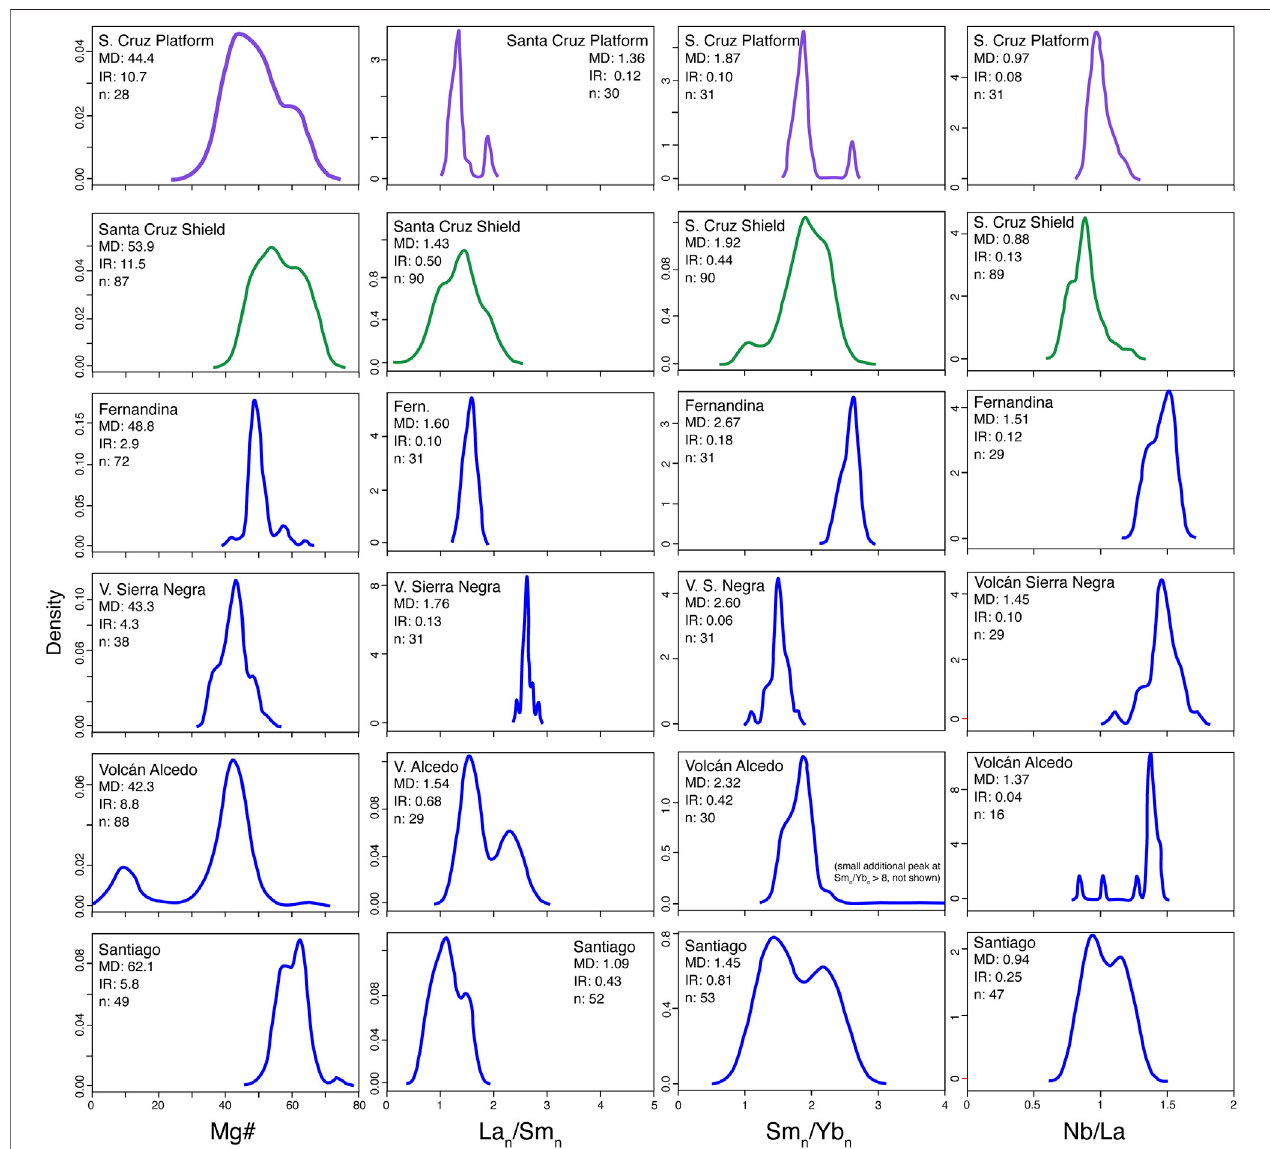
FIGURE 10 | Gaussian kernel distribution statistics for Mg# (proxy for extent of shallow fractionation), La n /Sm n (proxy for extent of melting), Sm n /Yb n (proxy for depth of melting), and Nb/La (proxy for plume contribution; Kurz and Geist, 1999) for Santa Cruz lavas, shown as Platform and Shield (all sub-groups treated together becausetheyeruptedcontemporaneously).AlsoshownforcomparisonarestatisticsfromFernandina(Whiteetal.,1993;KurzandGeist,1999;AllanandSimkin,2000), Volcán Sierra Negra (White et al., 1993; Reynolds and Geist, 1995), Volcán Alcedo (Geist et al., 1995), and Santiago (Gibson et al., 2012). MD is the maximum density and IR is the interquartile range, both determined using Wessa (2021). La, Sm, and Yb are normalized to chondrite values (McDonough and Sun, 1995).